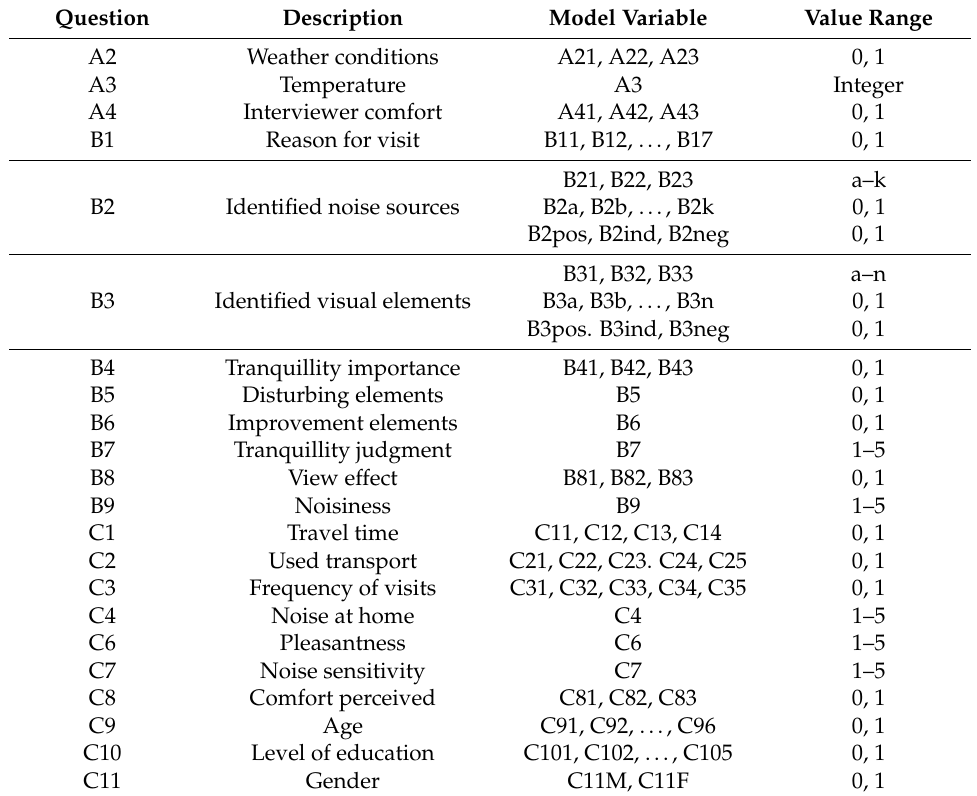
Table 3. Name, description of the variable and value range of each question of the